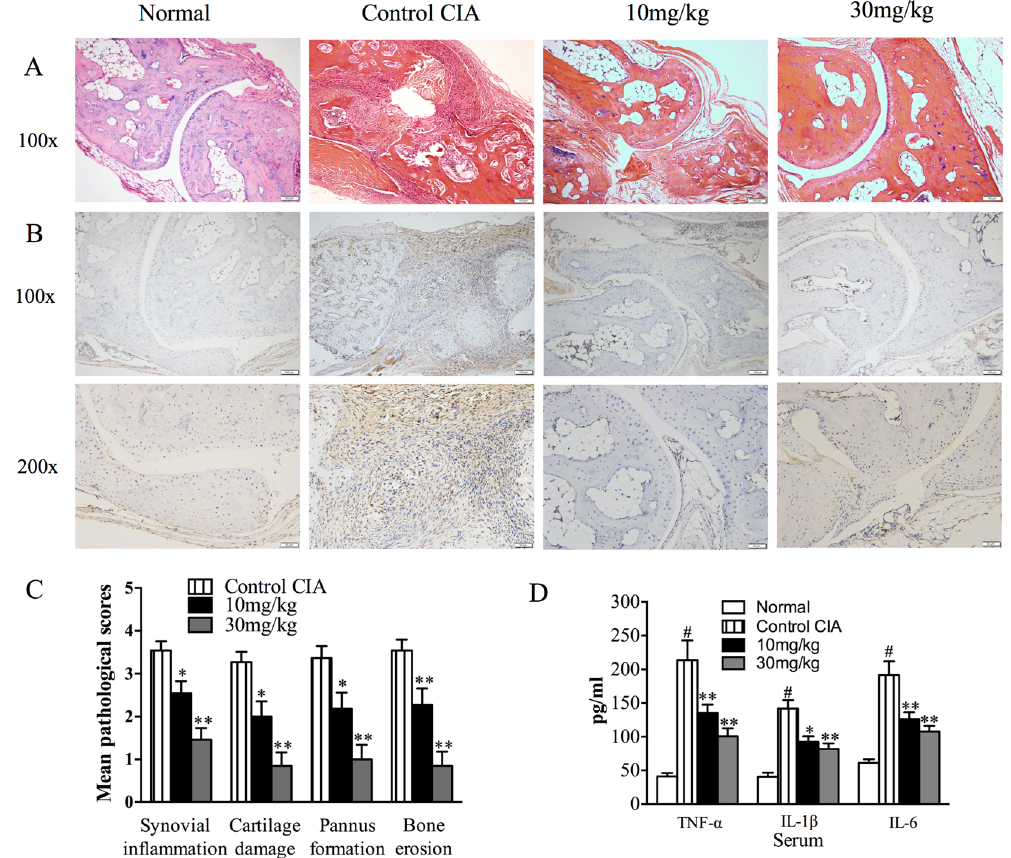
Figure 2. Effects of MASM administration on histopathological abnormalities and the production of pro- inflammatory cytokines in mice with CIA. ( A ) Hematoxylin and eosin (H&E) staining of the hind paws from the indicated different four groups. Original magnification x100. ( B ) Local tumor necrosis α (TNF- α ) expression in the hind paws tissues was measured by immunohistological staining. Original magnification x100 and x200. ( C ) Pathological scores determined as described in Materials and Methods. ( D ) The serum levels of TNF- α , IL-1 β and IL-6 were assessed by specific enzyme-linked immunosorbent assay (Elisa). Bars show the mean ± SEM (n = 10–15 mice per group). # P < 0.01 compared with normal group. * P < 0.05, ** P < 0.01 versus the control